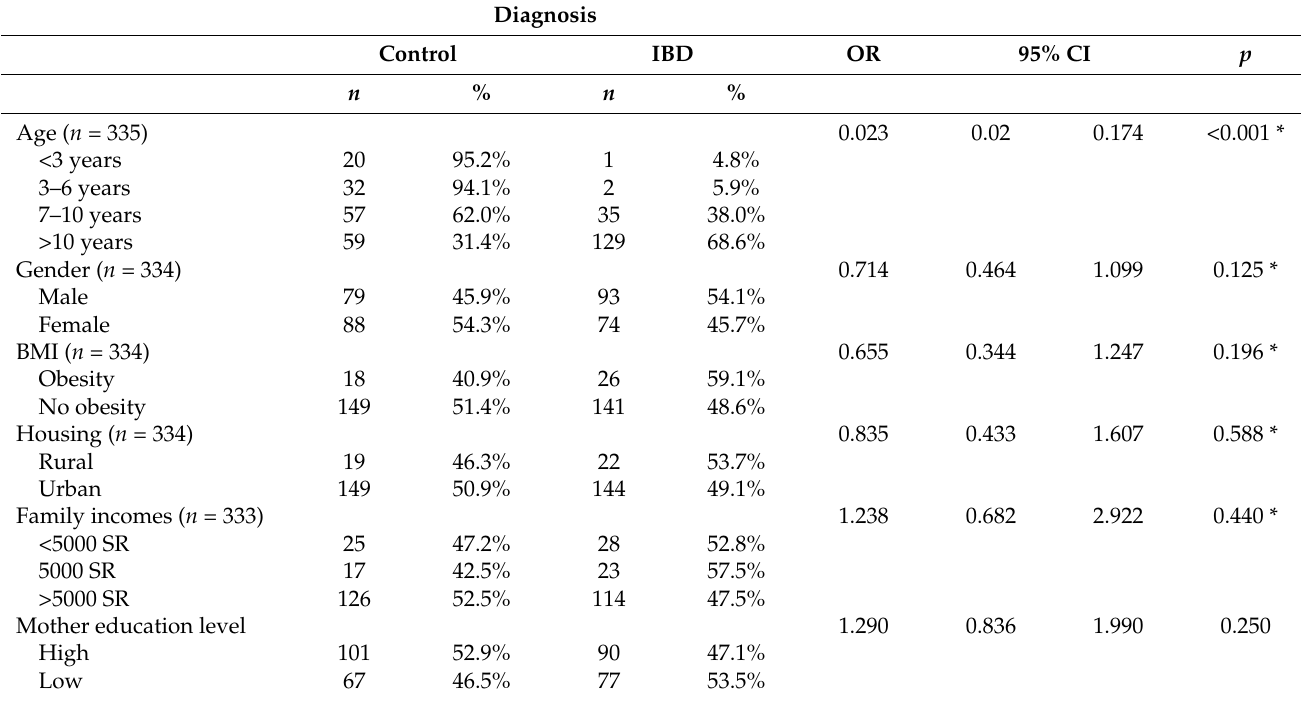
Table 2. Logistic regression analysis of demographic characteristics and their association/non- association with IBD